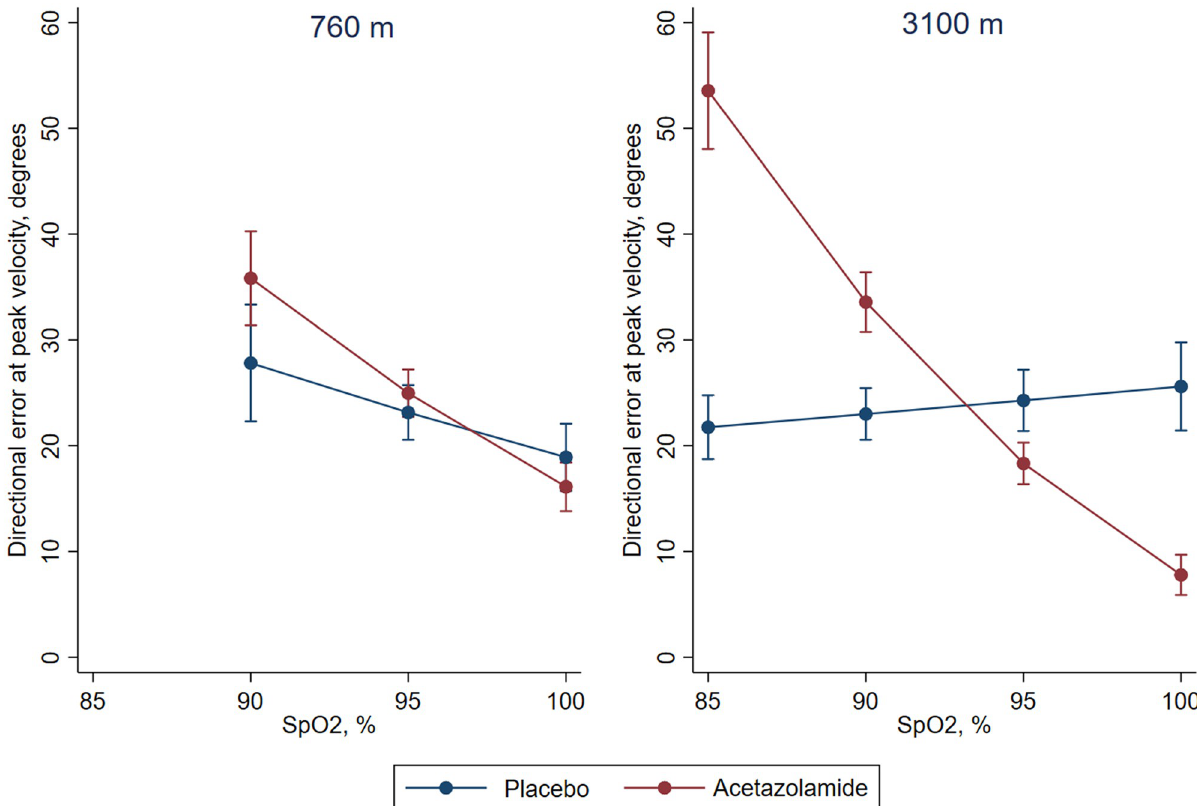
Fig 5. Effect of oxygen saturation on directional error. Average predicted margins of directional error at peak velocity as a function of pulse oximetry (SpO2) at 760 m baseline and at 3100 m altitude for patients taking placebo and acetazolamide, respectively.